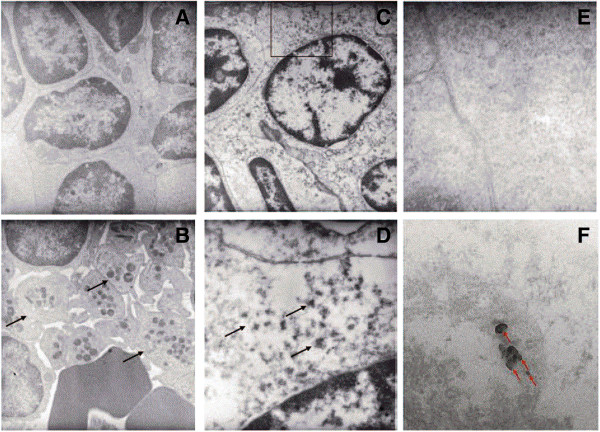
Transmission electron microscopy of the spleen. A: control animal, magnification 8000×; B: animal exposed to 10 mg/m3 SiO2.acrylate, magnification 8000×. Image showing accumulation of large numbers of thrombocytes (arrows); C: animal exposed to 10 mg/m3 SiO2.acrylate, magnification 8000×. The lymphocytic cytoplasm is less homogenous than that of the control animal. D: magnification (25 000×) of an indicated sector of panel C, showing small electron-dense aggregates within the lymphocytic cytoplasm (arrows). E: Magnification (50 000×) of lymphocytic cytoplasm of the control animal having a very homogenous structure. F: Animal exposed to 10 mg/m3 SiO2.acrylate, magnification 200 000×. Again, the lymphocytic cytoplasm is less homogenous than that of the control animal, and electron-dense particles are found within the cytoplasm. By EDX analysis, the electron-dense particles were identified as being silicon-rich.